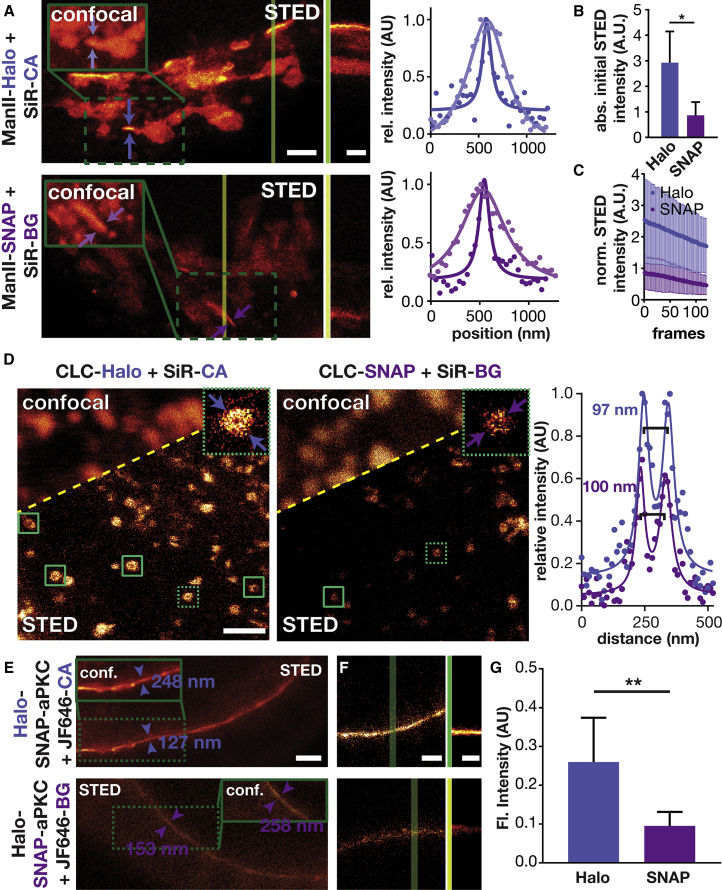
Comparison of Halo and SNAP Tagging in Live-Cell Super-Resolution Imaging(A) STED images of HeLa cells that are transiently expressing ManII-Halo or ManII-SNAP and that have been labeled with SiR-CA or SiR-BG, respectively (scale bar: 2 μm). The insets show the confocal image of the region highlighted with the green box. The vertical dark and light green lines indicate where the kymographs shown in the middle were taken (scale bar: 60 s). The plots show the average fluorescent signal as a function of position between the arrows shown in the confocal and STED images (dots, measured values; lines, fit).(B) Average initial intensity of STED movies of HeLa cells treated as described in (A) (n = 4 cells).(C) Average intensity over time of STED images of HeLa cells treated as described in (A) (n = 4 cells).(D) STED images of HeLa cells that are expressing Halo-CLC or SNAP-CLC and were labeled with SiR-CA or SiR-BG, respectively. The green boxes highlight clathrin-coated pits with a hollow center. Magnifications of the clathrin-coated pits highlighted with the dashed green boxes are shown in the upper right corner (scale bar: 1 μm). The plots show the average fluorescent signal as a function of position between the arrows shown in the STED images (dots, measured values; lines, fit).(E) STED images of Drosophila egg chambers expressing Halo-SNAP-aPKC that have been labeled with JF646-CA (top) or JF-646-BG (bottom). The insets show a confocal image of the area in the green dashed box. The values indicate the full-width half-maximum of line profiles taken between the arrowheads. Scale bar: 2 μm.(F) First frame of an STED video of Drosophila egg chambers that have been treated as described in (E). Scale bar: 1 μm. The green lines indicate where the kymographs shown next to it have been taken. Scale bar: 100 s.(G) Average initial intensity of STED movies of Drosophila egg chambers that have been treated as described in (E) (Halo, n = 4; SNAP, n = 6).